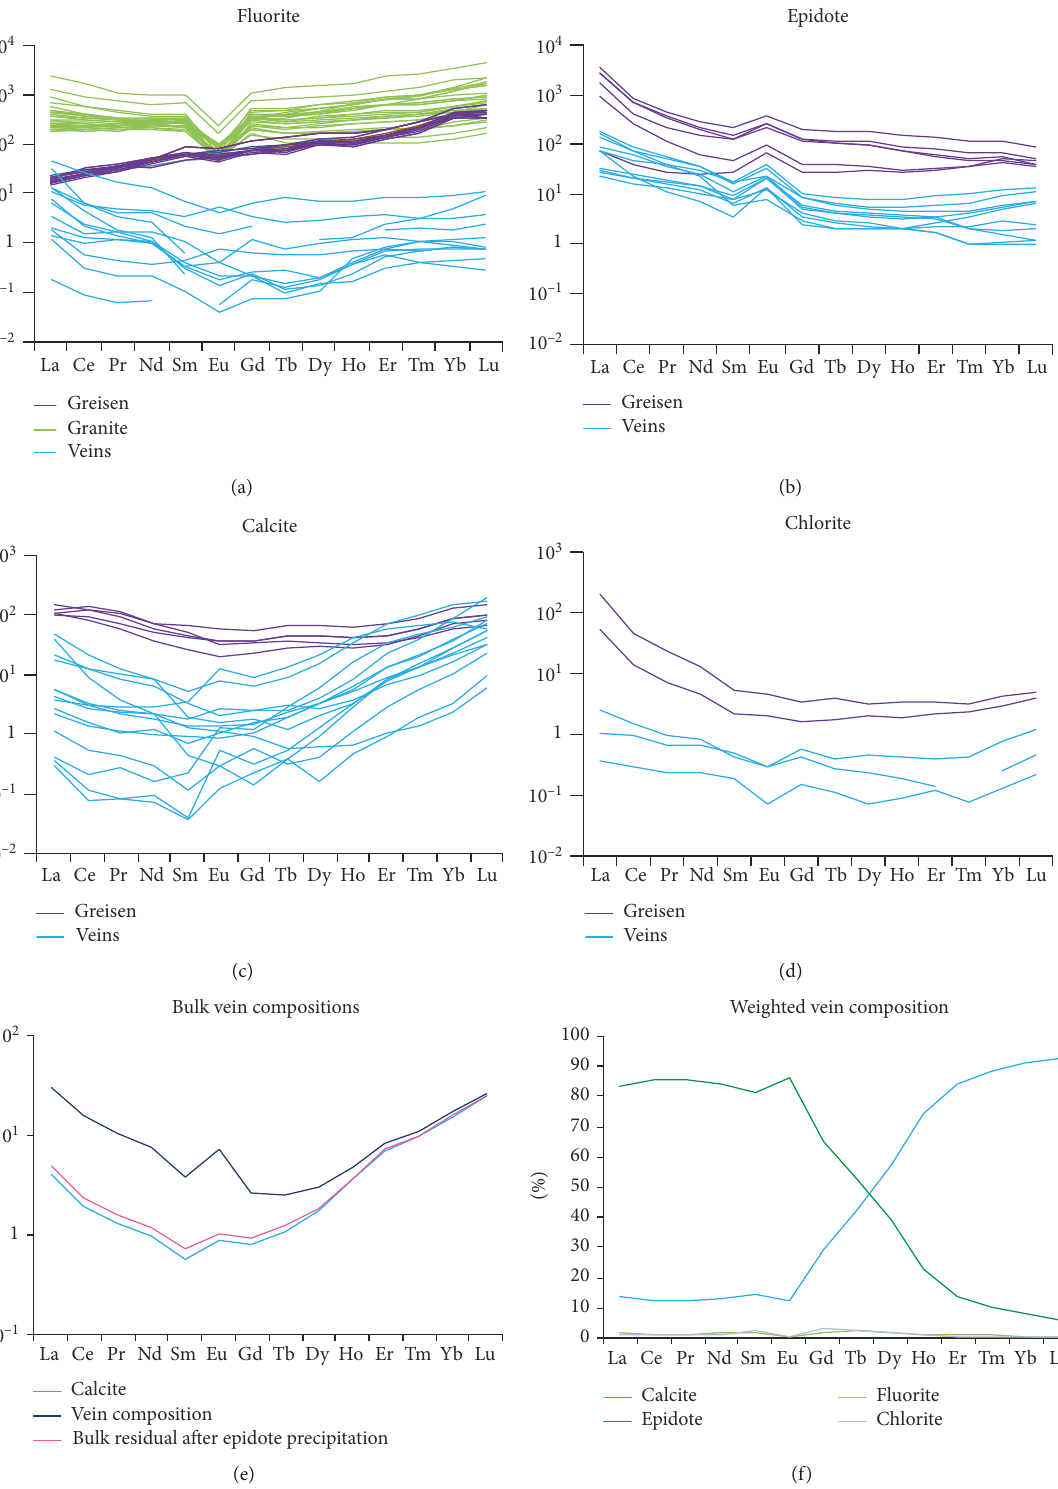
Figure 8: Comparison of chondrite-normalized REE concentrations in di ff erent sample types in (a) fl uorite, (b) epidote, (c) calcite, and (d) chlorite. (e) Chondrite-normalized [40] REE concentrations calculated for bulk vein, the residual remaining after the hypothetical withdrawal of epidote, and the contribution by calcite after epidote withdrawal (the epidote withdrawal and calcite contribution were calculated by multiplying the average REE concentrations for the mineral with its estimated mode in the veins), and (f) REE composition of vein minerals normalized to the estimated mineral mode of the